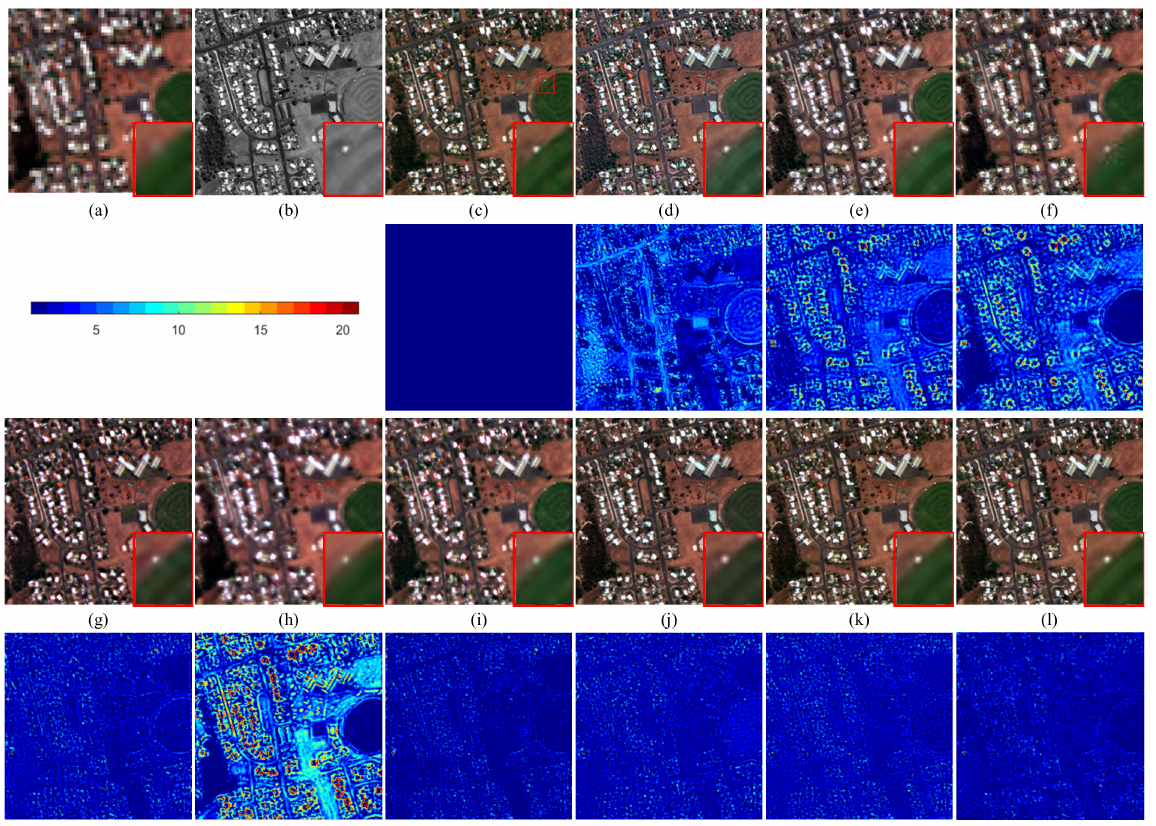
Figure 5. Visual analysis of the fused images from different methods on the GeoEye-1 dataset. ( a ) LR MS image; ( b ) PAN image; ( c ) reference image; ( d ) BDSD; ( e ) SVT; ( f ) VPLGC; ( g ) A-PNN; ( h ) DRPNN; ( i ) PanNet; ( j ) PSGAN; ( k ) TFNet; ( l ) MSIT.